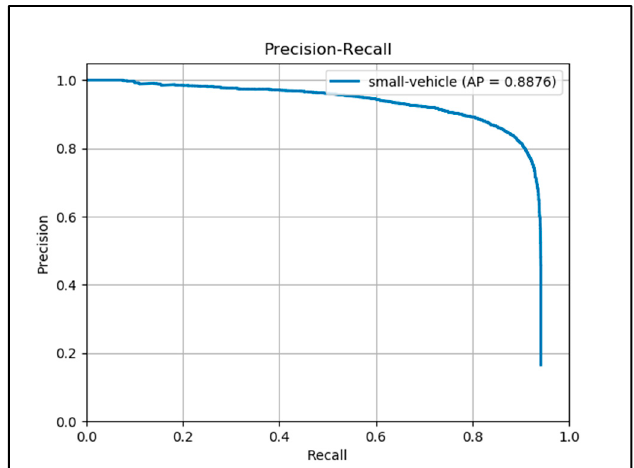
Figure 12. P-R curve of Framework 1.2 on DOTA.